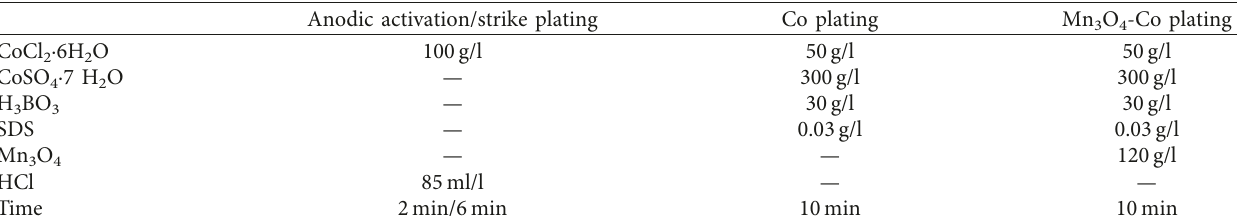
Table 2: Solution composition and time for anodic activation, pure cobalt plating, and Mn